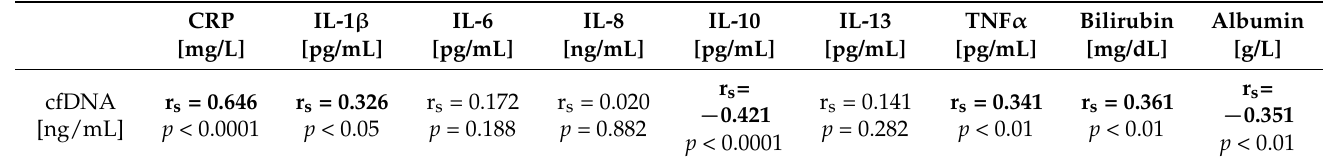
Figure 4. The relationship between cell-free DNA (cfDNA) and C-reactive protein (CRP) to albumin ratio ( n = 60); r s , Spearman’s rank correlation coefficient. 4. Discussion Nutritional deficiencies and low physical activity, which are common among people aged over 65 years, cause an essential loss of physiologic reserves, making the individual susceptible to the activity of inflammatory mediators [35]. Earlier, we investigated the relationship between lifestyle exercise and percentage of CD4+ and CD8+ naïve and memory T lymphocytes as well as CD4/CD8 ratio in active compared to inactive older individuals [19]. Furthermore, we also analysed changes in inflammatory pattern in response to physical exercise intervention [22]. In the present study, we focused on the profile of circulating pro- and anti-inflammatory mediators in conjunction with nutritional status and physical performance resulting from daily activity. The diet analysis showed nutritional frailty in the intake of the major ingredients, which may influence the rate of inflammaging. In both analysed groups, LGI and HGI, poor compliance with the recommended dietary intake nutrients and food components was